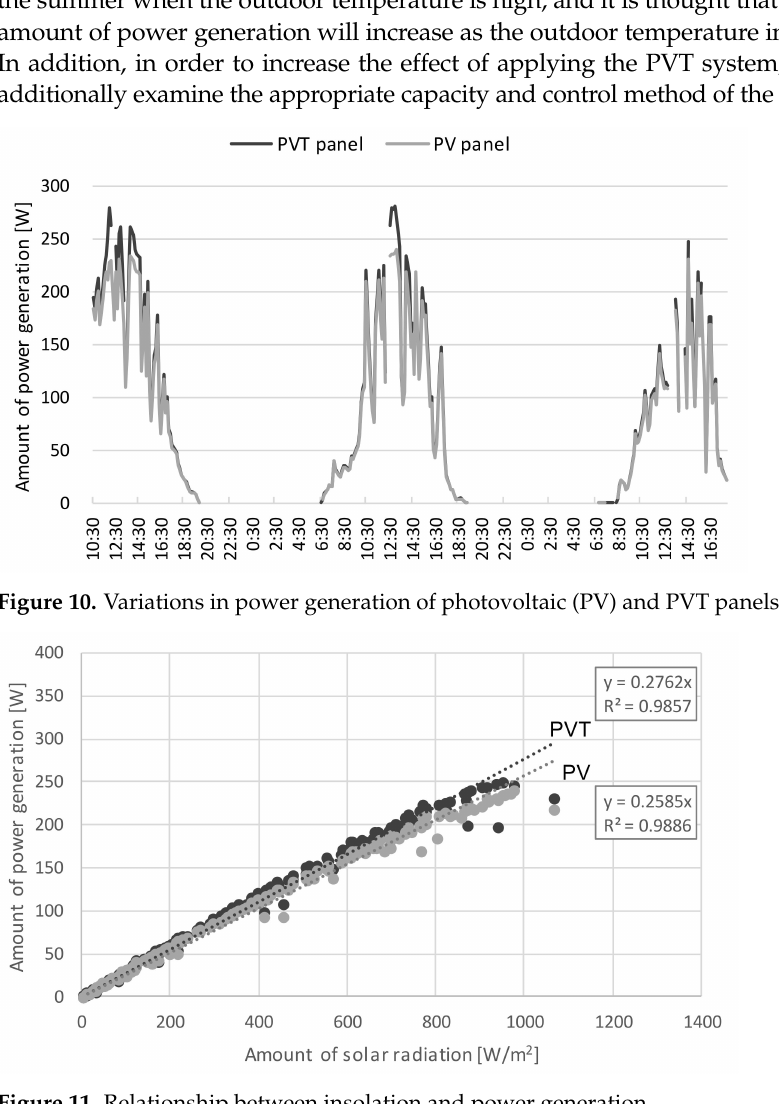
Figure 11. Relationship between insolation and power